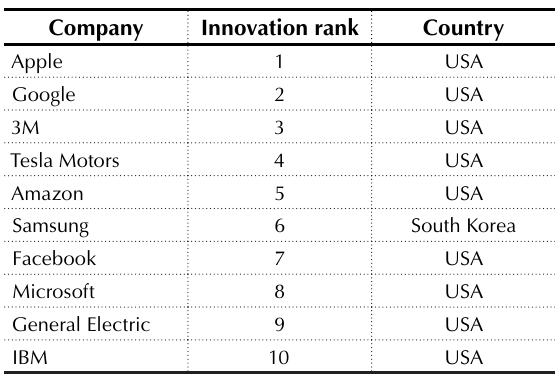
Table 1. The 2016 Innovation Ranking by Strategy&